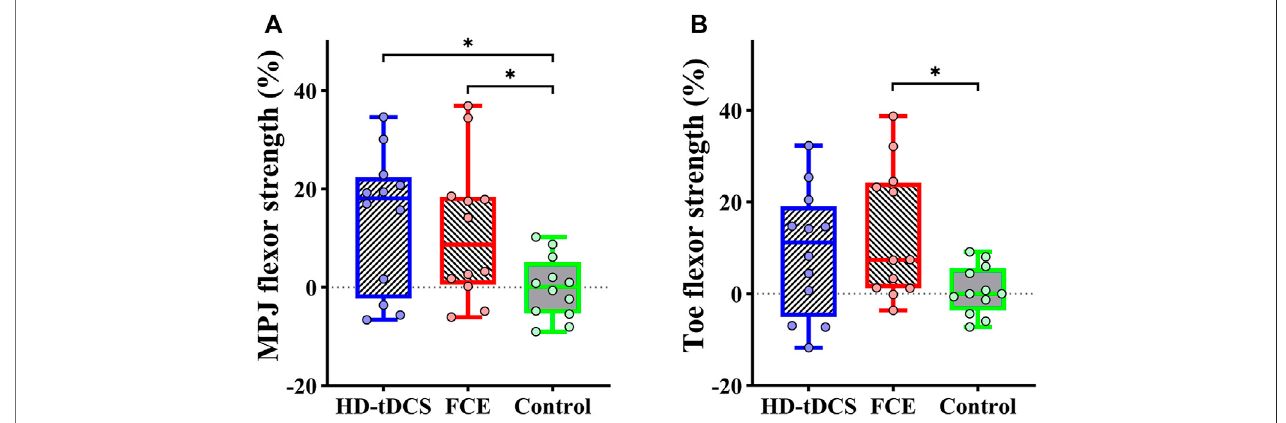
FIGURE5| Differencesinpercentchangesinone-legstandingbalancefrombaselinetopost-interventionamonggroups. (A) MLCoGswayvelocityinOL_EO; (B) AP CoG sway velocity in OL_EO; (C) ML CoG sway velocity in OL_EC; (D) AP CoG sway velocity in OL_EO. OL_EO: one-leg standing with eyes open; OL_EC: one-leg standingwitheyesclosed;ML:medial – lateral;AP:anteroposterior;CoG,centerofgravity;HD-tDCS:high-de fi nitiontranscranialdirectcurrentstimulation;FCE:footcore exercise; p p <